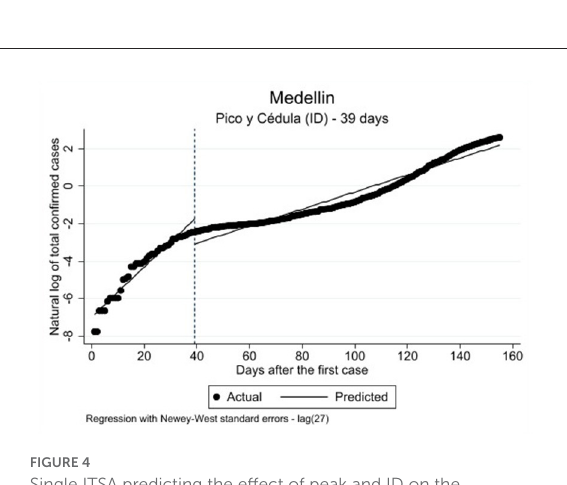
FIGURE4 Single ITSA predicting the effect of peak and ID on the COVID-19 infection rate in Medellin; the interruption time-point of the analysis is 14 days after the actual implementation of the